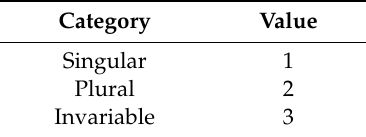
Table 7. Mapping rules for